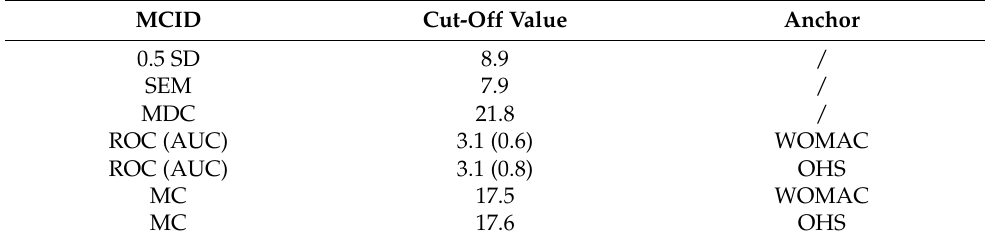
Table 1. MCID for FJS-12 calculated by both distribution-based and anchor